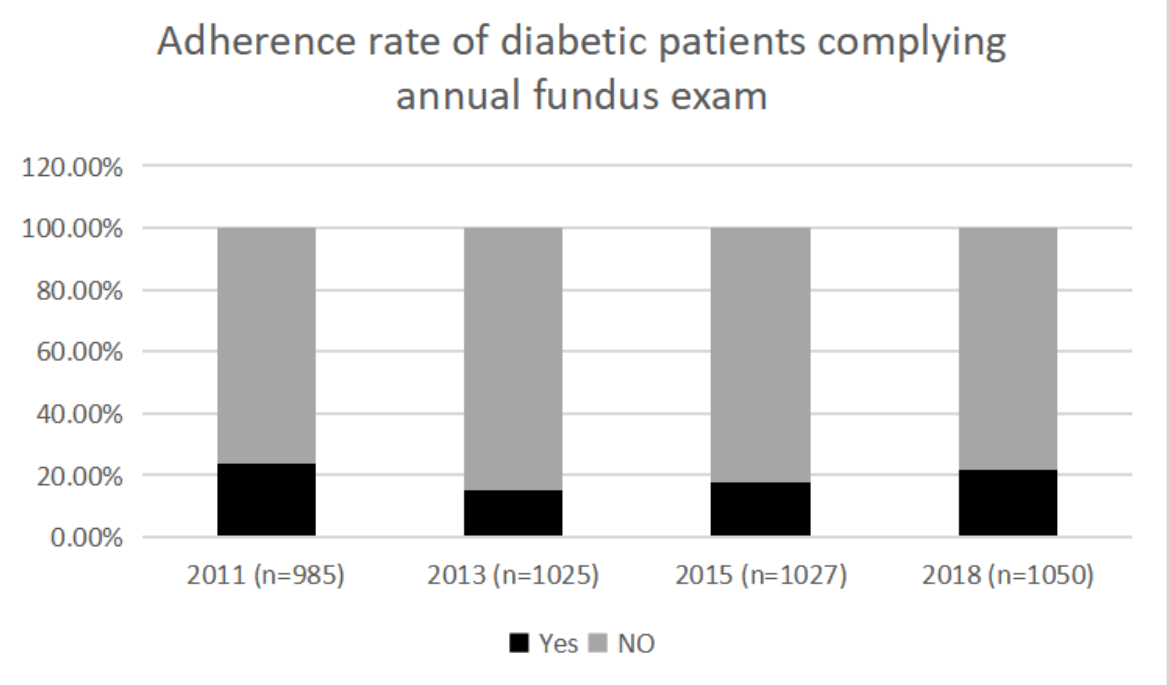
Figure 2. Adherence rates of participants with diabetes in CHARLS from 2011 to 2018.